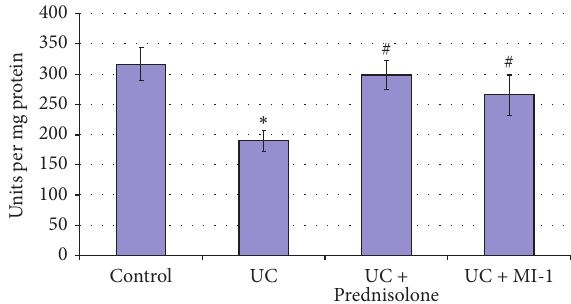
Figure 5: Bowel mucosa SOD activity for rats experiencing UC and treated with Prednisolone and MI-1. ∗ 𝑝 ≤ 0.05 compared with control group; # 𝑝 ≤ 0.05 compared with UC group.